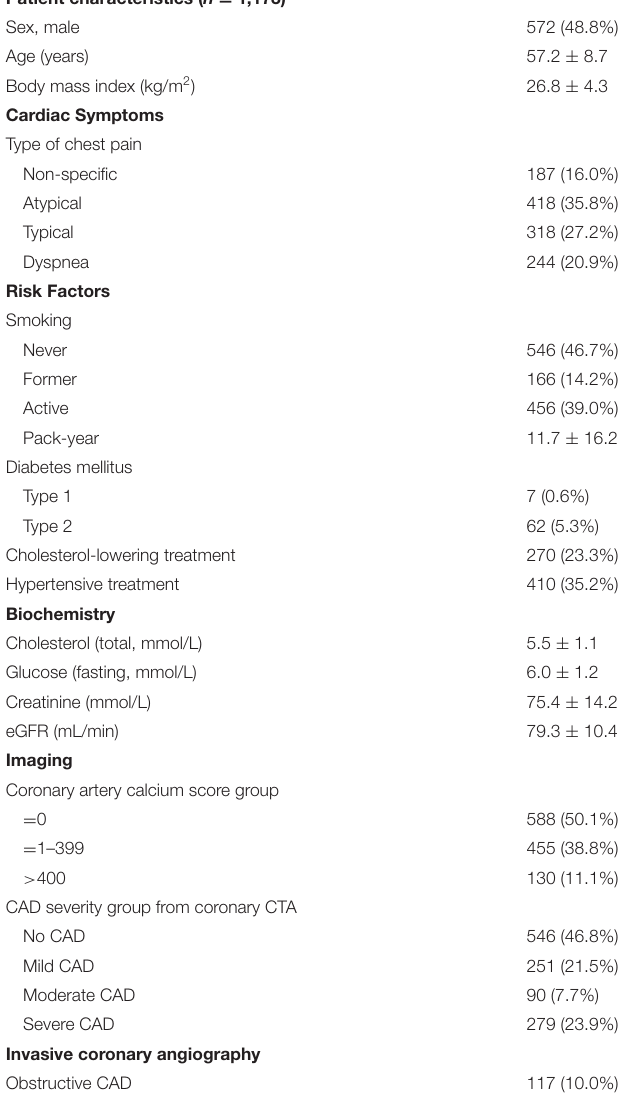
TABLE 1 | Cohort description ( n =